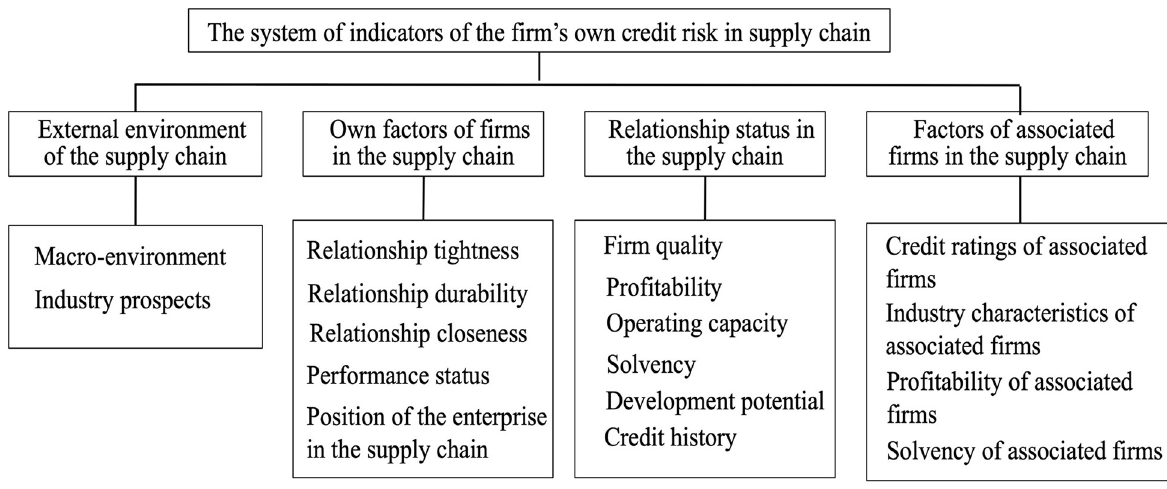
Fig 2. The system of indicators of firm’s own credit